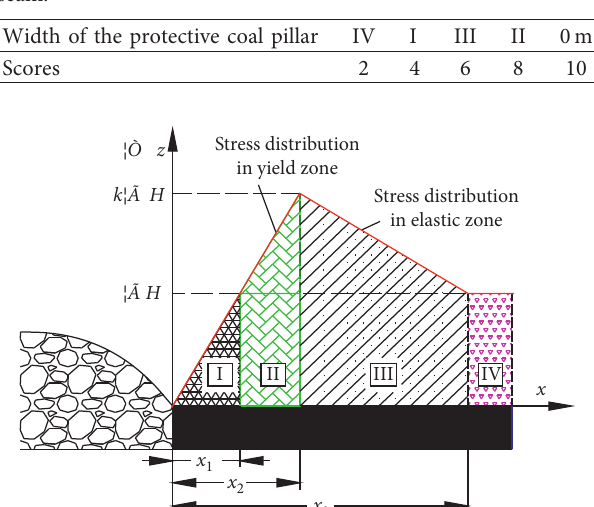
) , II: overstressed plastic 1 ) , and < x ≤ x 2 3 ) 3